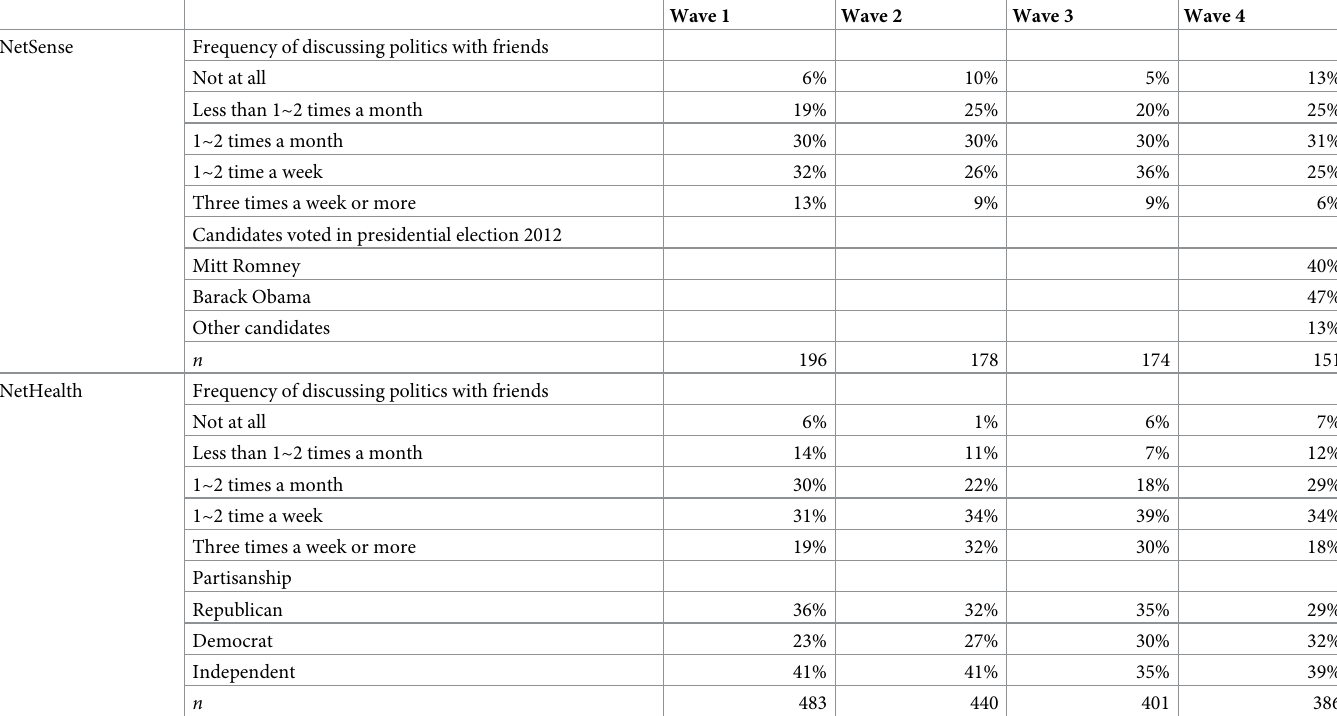
Table 4. Summary statistics of political factors among NetSense and NetHealth study participants.